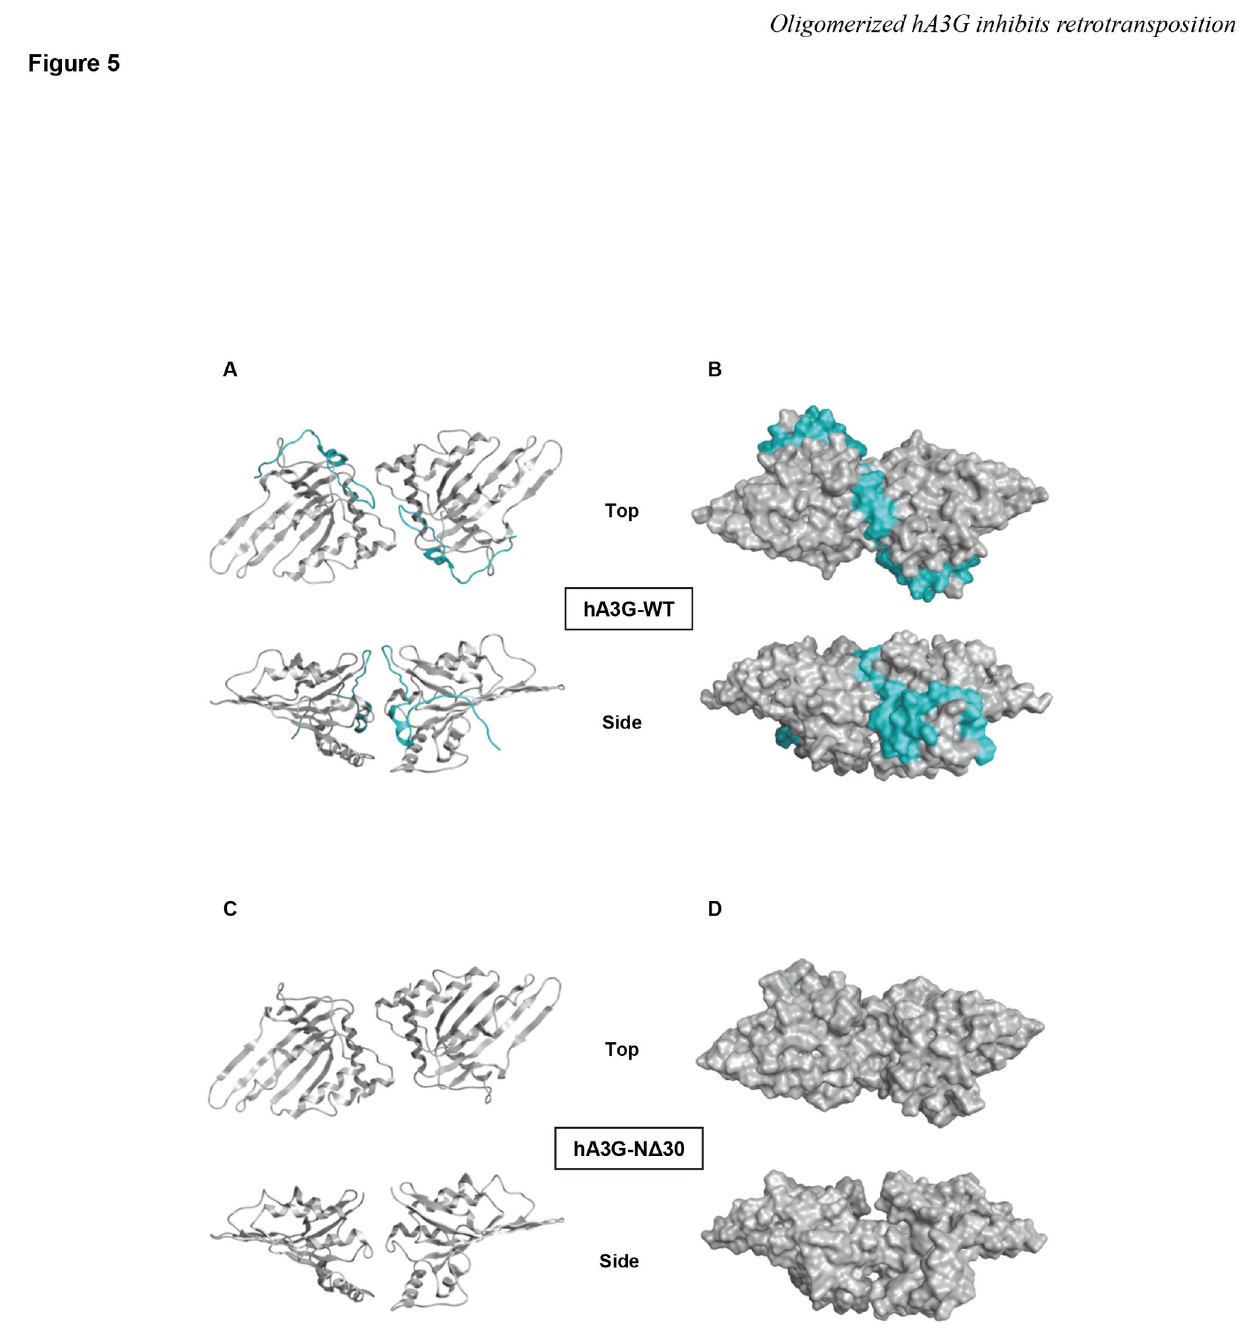
Figure 5. The N-terminal 30 amino acids of hA3G are located at the dimer interface and are therefore key residues for the oligomerization of hA3G. Structural models of the hA3G N-terminal domain. The models were constructed by homology modeling using the X-ray crystal structure of hA2. The head-to-head dimer structure of hA3G N-terminal domain is represented by ribbon models (A and C) and space-filling models (B and D). ( A , B ) Views of the top (upper) and side (lower) of wild-type (WT) hA3G. Cyan, N-terminal 30 amino acids of hA3G. ( C , D ) Views of the top (upper) and side (lower) of the N-terminal 30-amino-acid deletion mutant of hA3G.